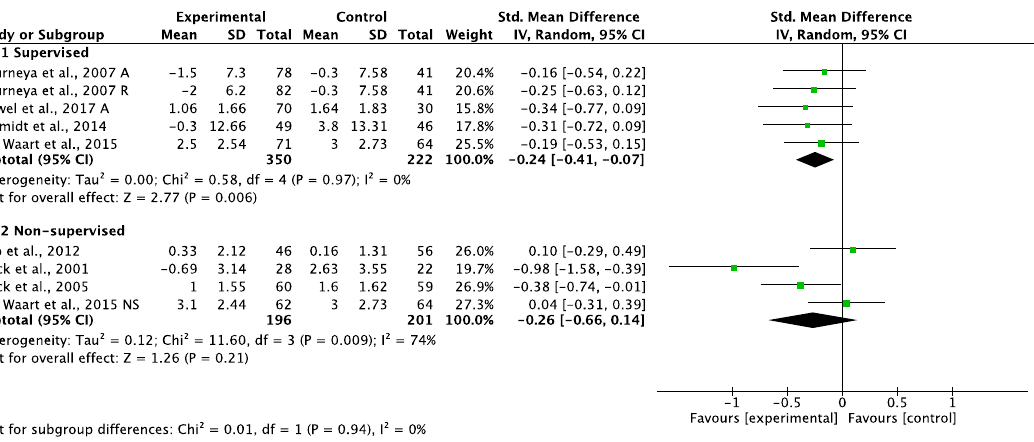
Figure 7. Meta-analyses of the effects of supervised [46,51,52,64] and non-supervised [36,37,41,51] exercise interventions of less than 80% adherence on CRF in BC patients. A: aerobic exercise group; NS: non-supervised exercise group; R: resistance exercise group.